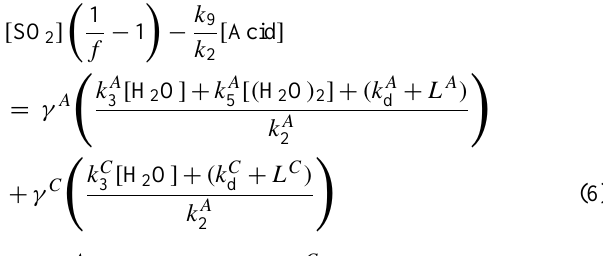
k 5 /k 2 = 0.014 ( ± 0.018). This still gives a good fit to the